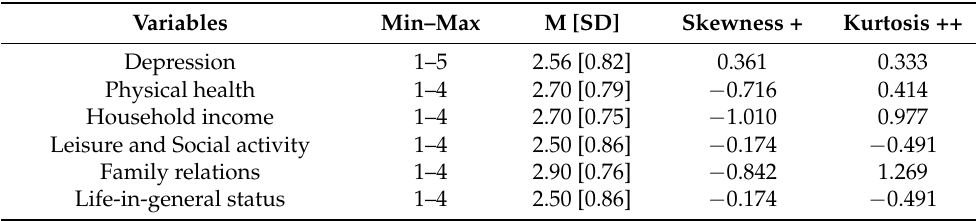
Table 2. Depression, physical health, household income, leisure and social activity, family relations, life-in-general status in